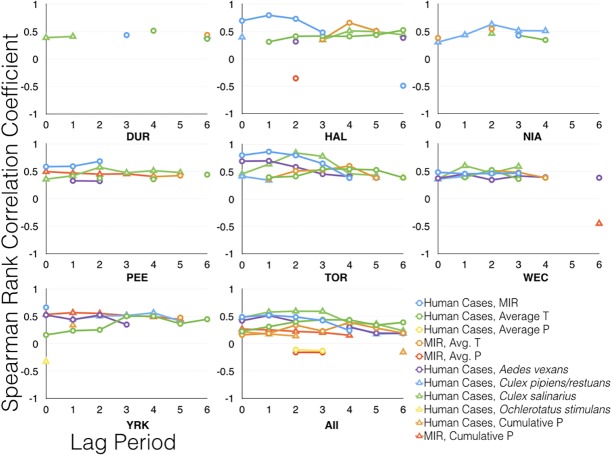
Spearman rank correlation coefficients for analyses of WNV epidemic years, 2002 and 2012.All, combined data from all HUs. Only significant (p < 0.05) data are presented.